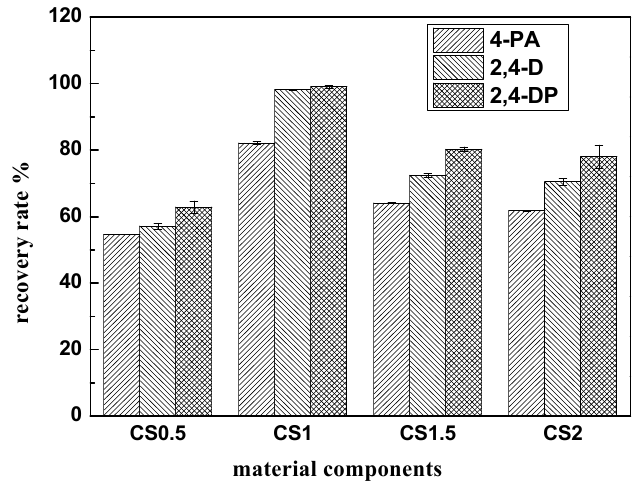
Figure 7. The effect of material composition on the magnetic solid phase extraction.